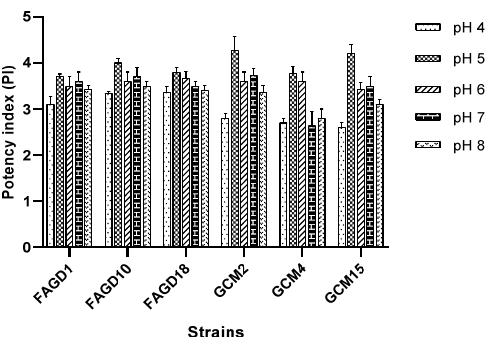
Figure 2. Phylogenetic relationships of the six strains and AAB species based on 16S rRNA gene sequences. Lactobacillus plantarum was used as outgroup.